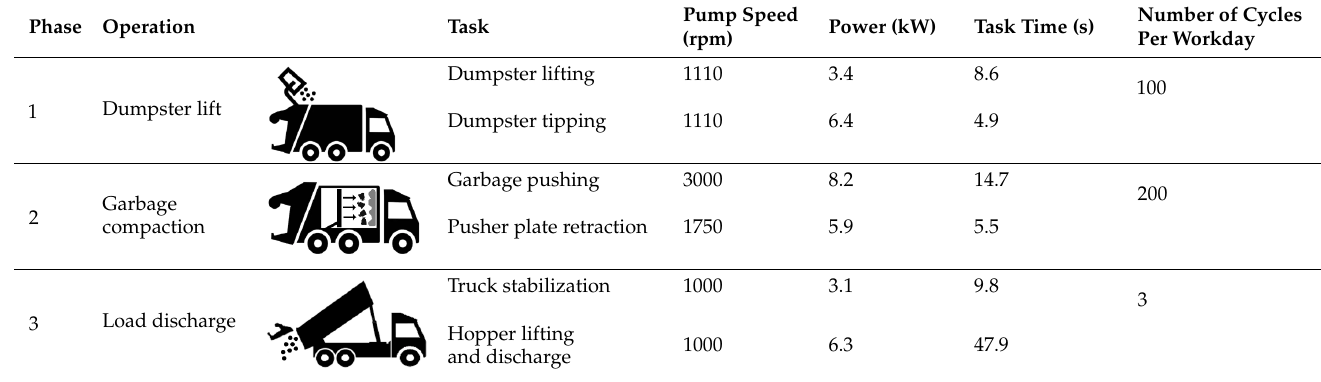
The sequence of collection tasks is composed of one hundred repetitions of one dumpster lift followed by two garbage compactions. The three load discharges are tem- porally equally distributed with the collection activities. Table 1. Garbage collection operations and tasks executed by the compactor truck with related mechanical power and task times. Phase Operation